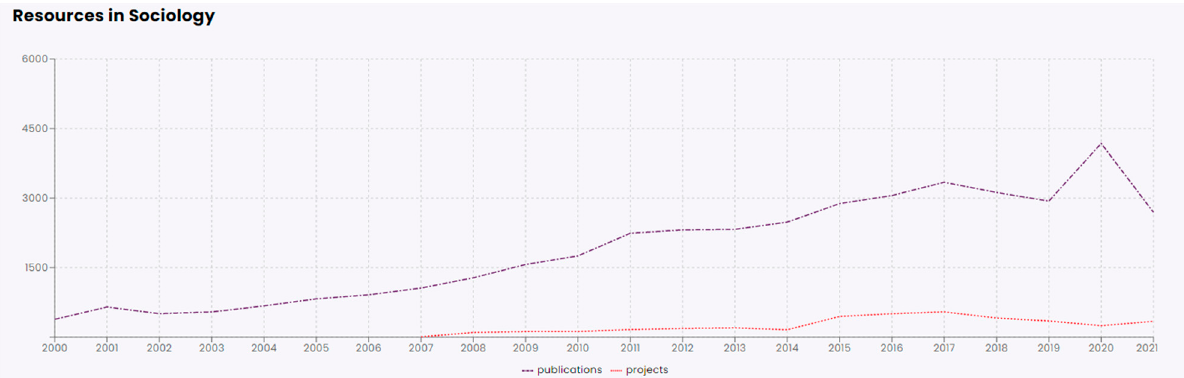
Figure 2. Example of a component of the GoTriple discipline dashboard (see https://www.gotri- ple.eu/disciplines, accessed 12 August 2022) showing the number of projects and publications dis- coverable for sociology over time.